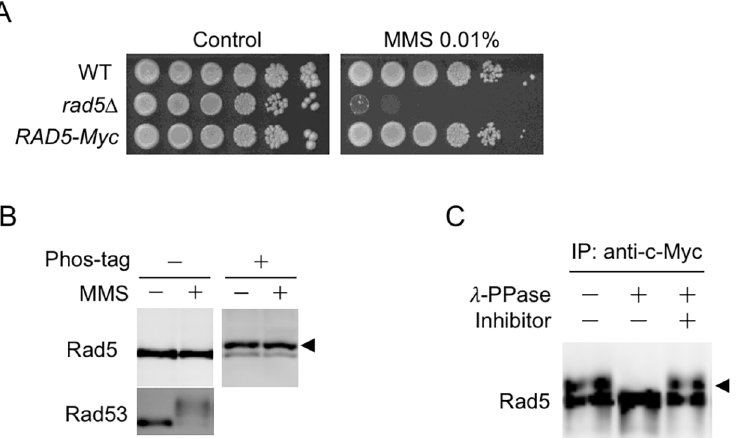
Fig 1. Rad5 phosphorylation under normal growth conditions. (A) MMS sensitivity of wild-type, rad5 Δ and RAD5-Myc cells. Ten-fold serial dilutions of asynchronous cell cultures were spotted onto YPDA plates with or without MMS (0.01%) and incubated at 30˚C for 3 days. (B) Detection of Rad5 phosphorylation by western blotting with anti- c-Myc antibody. Log-phase cultures of wild-type RAD5-Myc cells were either mock treated (-) or treated with 0.1% MMS (+) for 1 h. Protein extracts were then processed on a standard SDS-PAGE gel and on a Phos-tag SDS-PAGE gel. Rad5 and Rad53 proteins were detected with anti-c-Myc and anti-Rad53 antibodies, respectively. The slower migrating bands are indicated by arrow heads. (C) Immunoprecipitated Rad5 was treated with lambda phosphatase (or mock treatment) and phosphatase inhibitors prior to Phos-tag SDS-PAGE, followed by immunoblotting with anti c-Myc antibody.